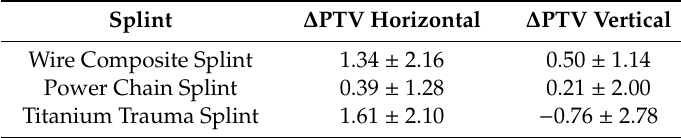
Table 9. Splint e ff ects ( ∆ PTV) for central incisors.